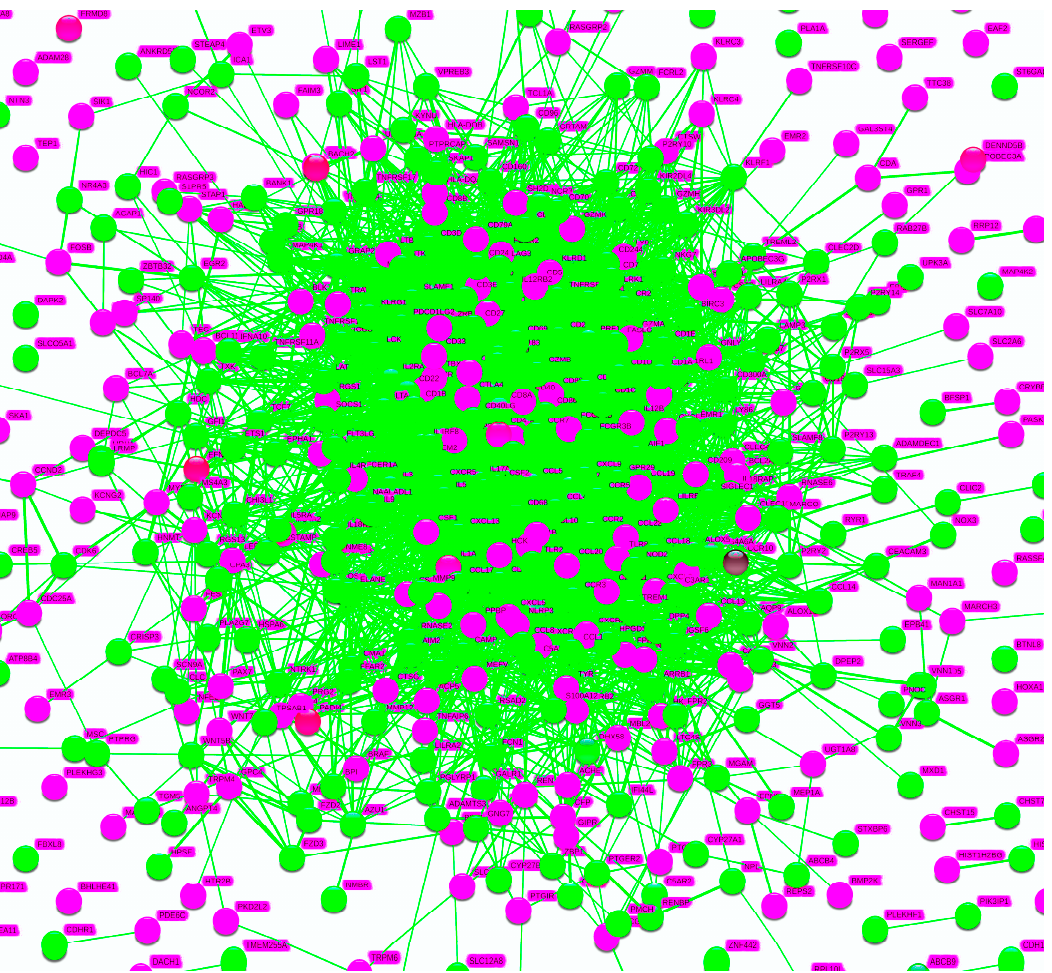
Figure 2. Protein–protein interaction (PPI) network of LM22 on STRINGdb. STRINGdb analysis of LM22 presented a cluster that is very interrelated, an almost ball-shaped aggregate. In total, 51 pathways were identified which were all related to immune reactions of the human body.